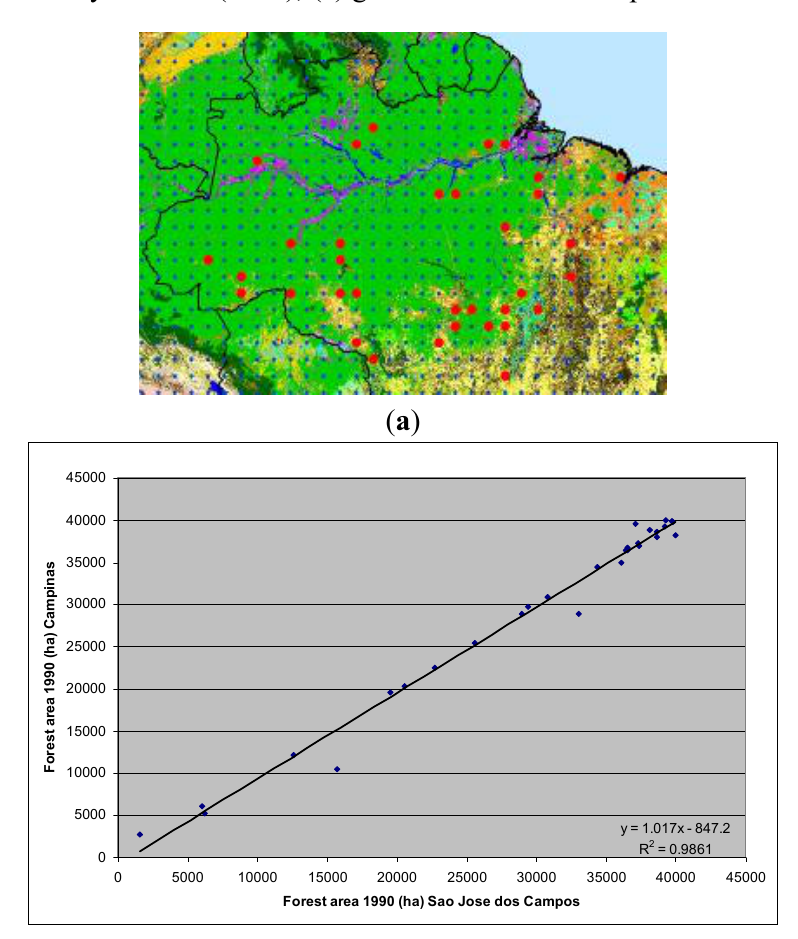
Figure 3. Comparison between sites interpreted by the Instituto Nacional de Pesquisas Espaciais (INPE) and by our interpreters: ( a ) location of the 34 random sample sites; ( b ) forest cover for year 1990 (in ha); ( c ) gross deforestation for period 1990–2000 (in